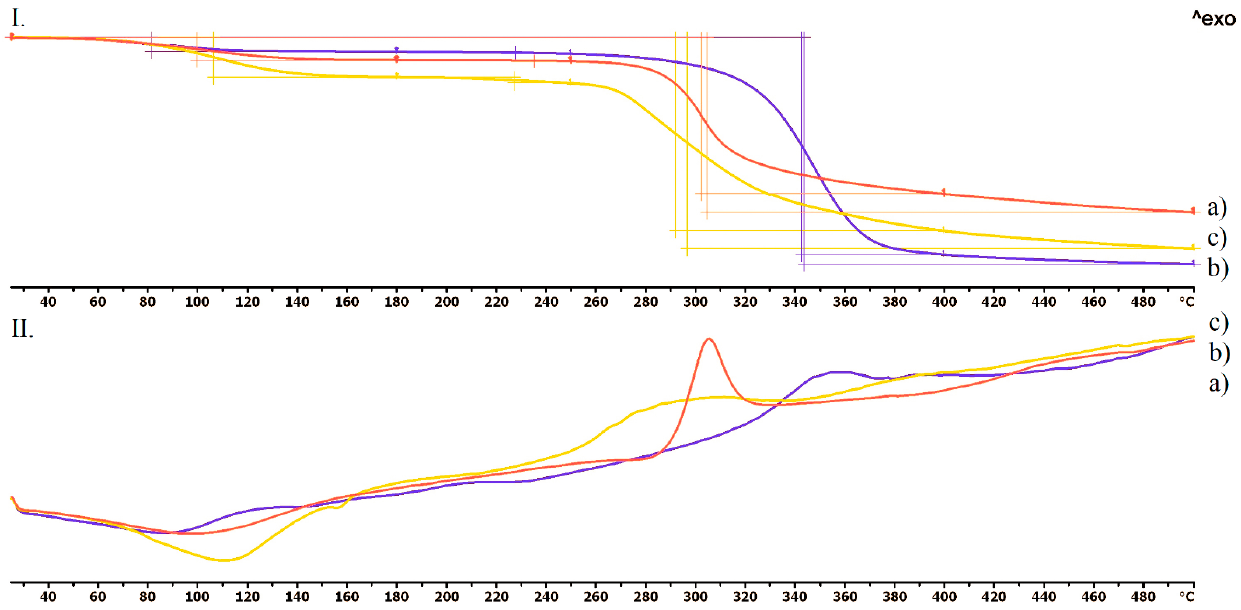
Figure 5. Thermogravimetric ( I ) and heatflow ( II ) analysis of the chitosan ( a ), hydroxyethyl cellulose ( b ) and agar ‐ agar ( c ). Thermal behavior was analyzed between 25 °C and 500 °C.